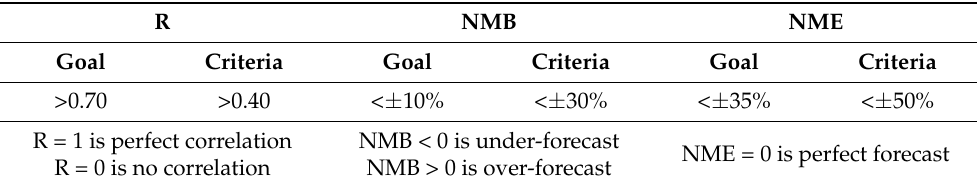
Table 4. Goals and criteria of the R, the normalized mean bias (NMB) and the normalized mean error (NME) for the forecast of daily mean PM 2.5 concentrations.